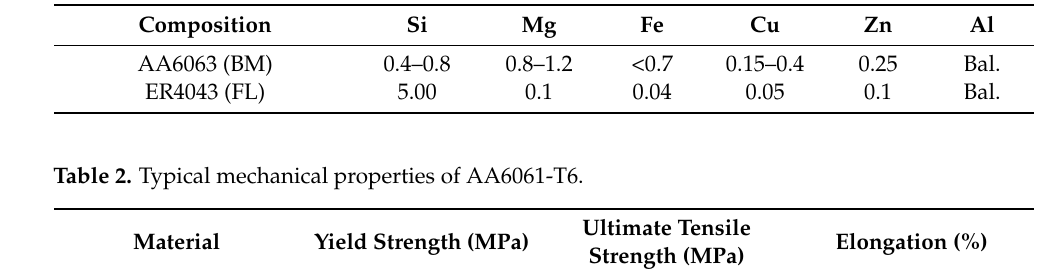
Table 1. Chemical composition of 6061 and 4043 aluminum alloy (wt%).